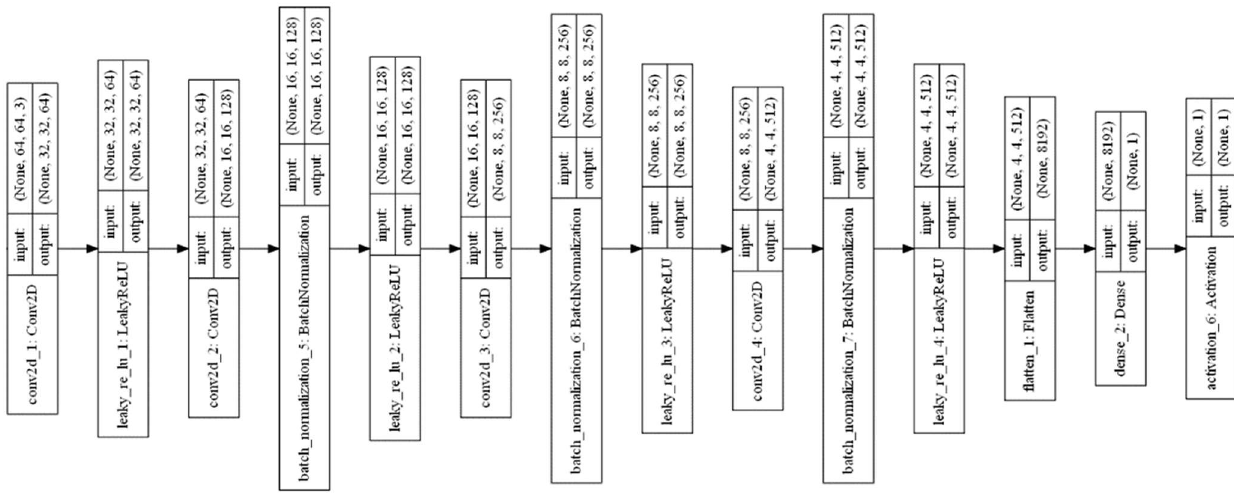
Figure 5. Layered structure of DCGAN discriminator.